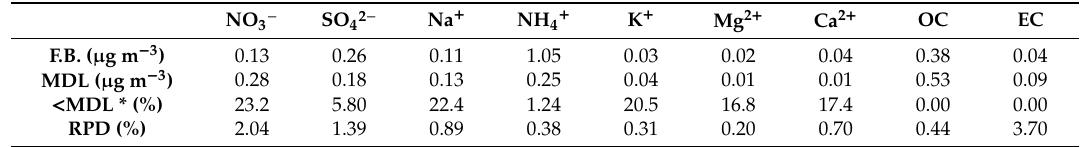
Table 2. Summarized QA / QC results for particulate matter (PM 2.5 )